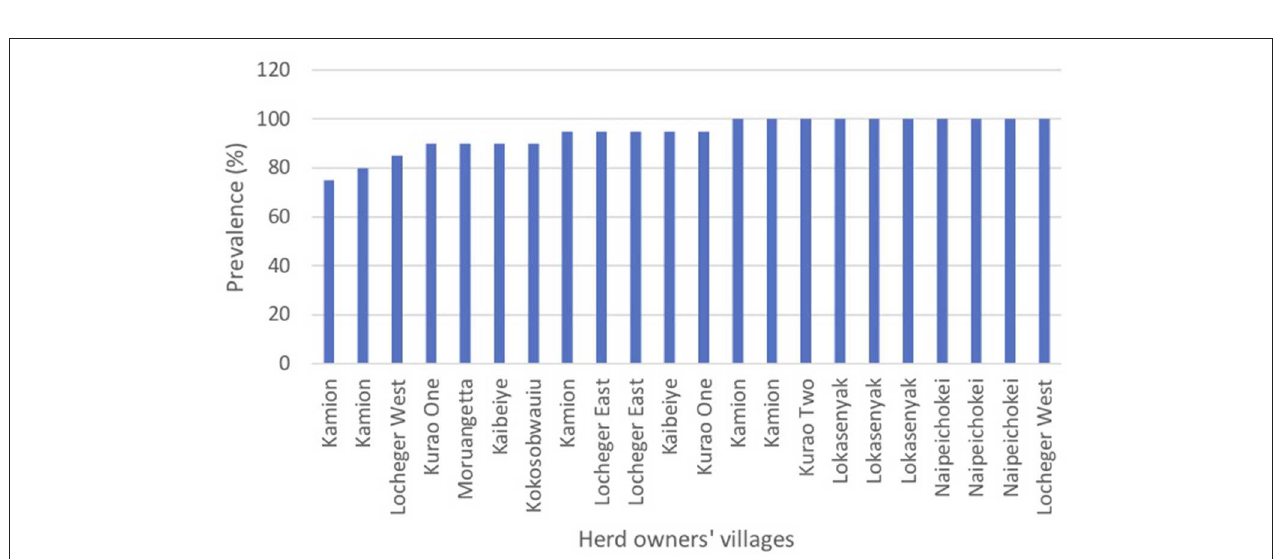
FIGURE 8 | Serosurvey results from the Kamion outbreak investigation in the northern transmission focus (Kotido-Kaabong). The serosurvey following the outbreak in the Kamion & Kalapata security kraals that housed herds from numerous villages found uniformly high seroprevalences. The labels represent the home villages of the herds sampled at the security kraals. Ten of the herds sampled were 100%